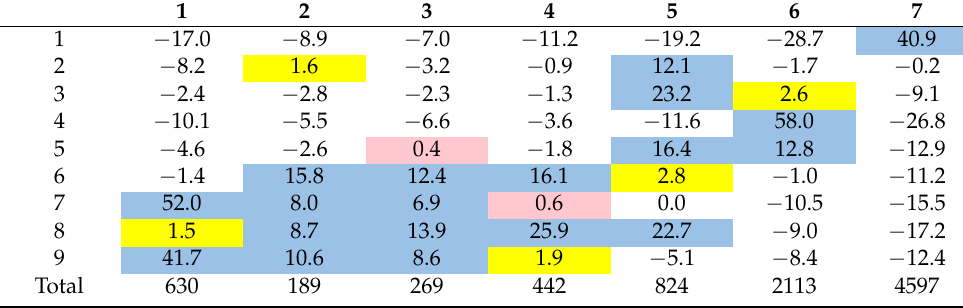
Table A15. Theoretical frequencies AFWW 2006